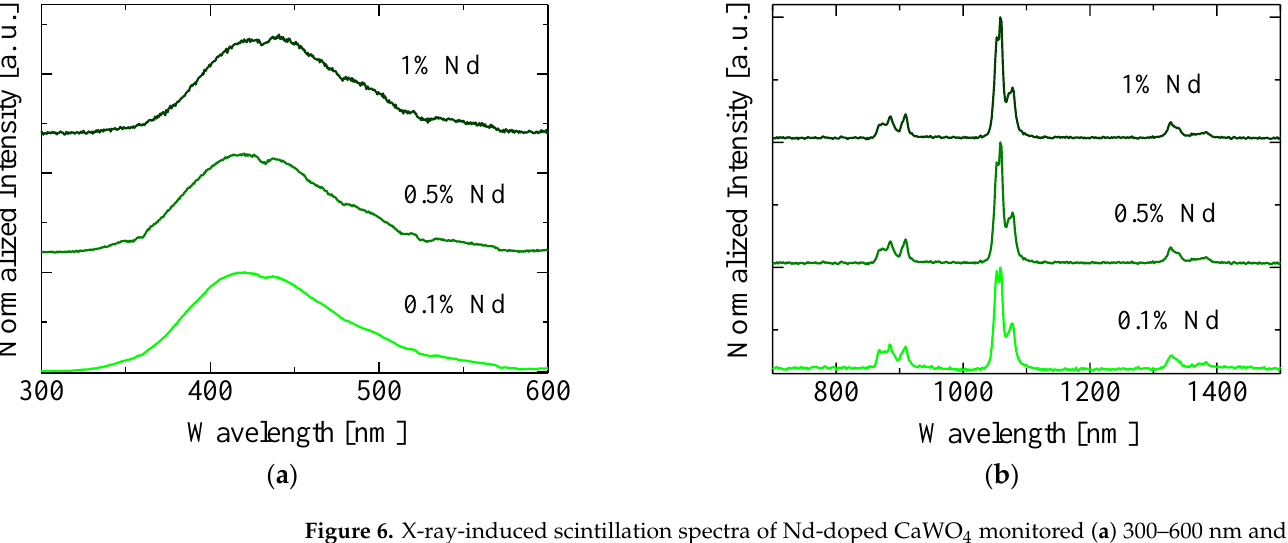
Figure 6. X-ray-induced scintillation spectra of Nd-doped CaWO 4 monitored ( a ) 300 – 600 nm and ( b ) 700 – 1500 nm. The X-ray-induced scintillation decay curves monitored at the range from UV to vis- ible light are exhibited in Figure 7a. They were well agreed with a sum of two exponential functions. The origin of the fast (~1 μs ) and slow (~5 – 7 μs ) components were respectively considered to be the WO 3 – V O complex defects and the charge transfer transitions in (WO 4 ) 2- anion complex because the confirmed decay times were comparable with the scin- tillation decay times of CaWO 4 , reported in the past study [43]. The slow components be- came fast as the Nd concentration increased. It presented that the energy transfer from the